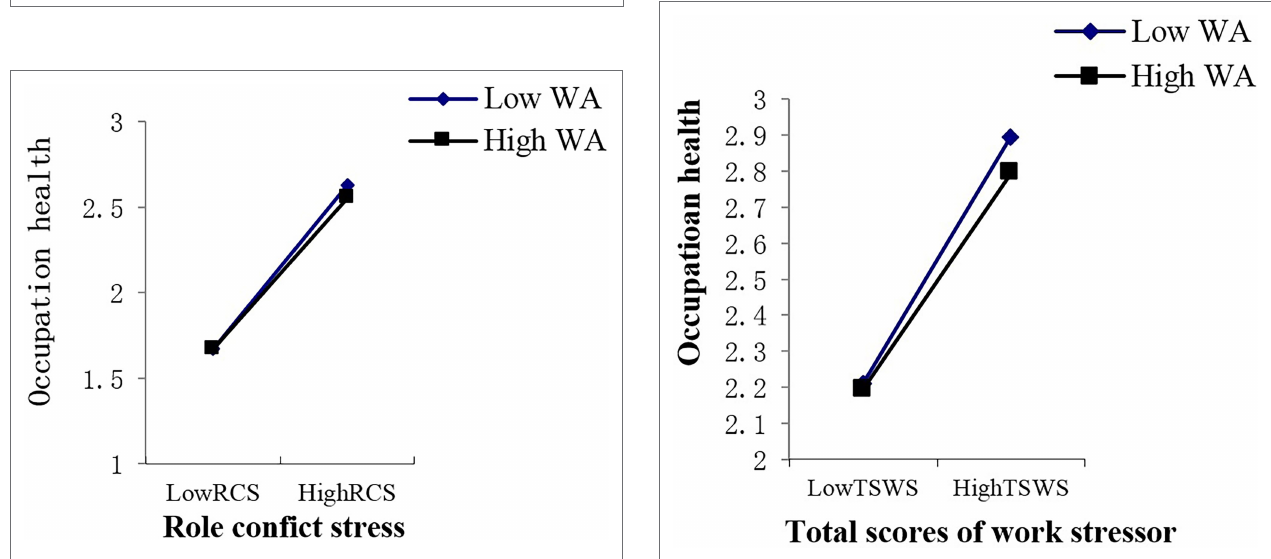
FIGURE 3 | Interactive effects of WA and IRS on OH. WA, work adaptability; IRS, interpersonal relationship stress; OH, occupation health.